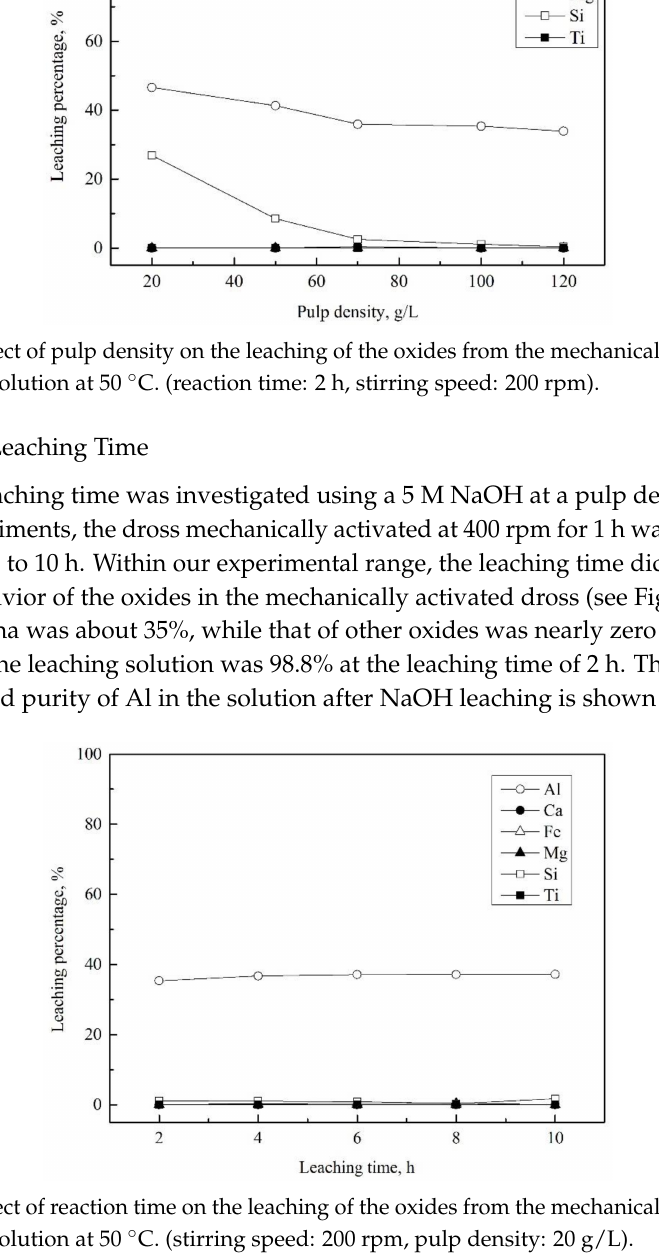
Table 3. The composition of the leaching solution and the purity of Al in the solution after NaOH leaching of the mechanically activated dross at the optimum condition.